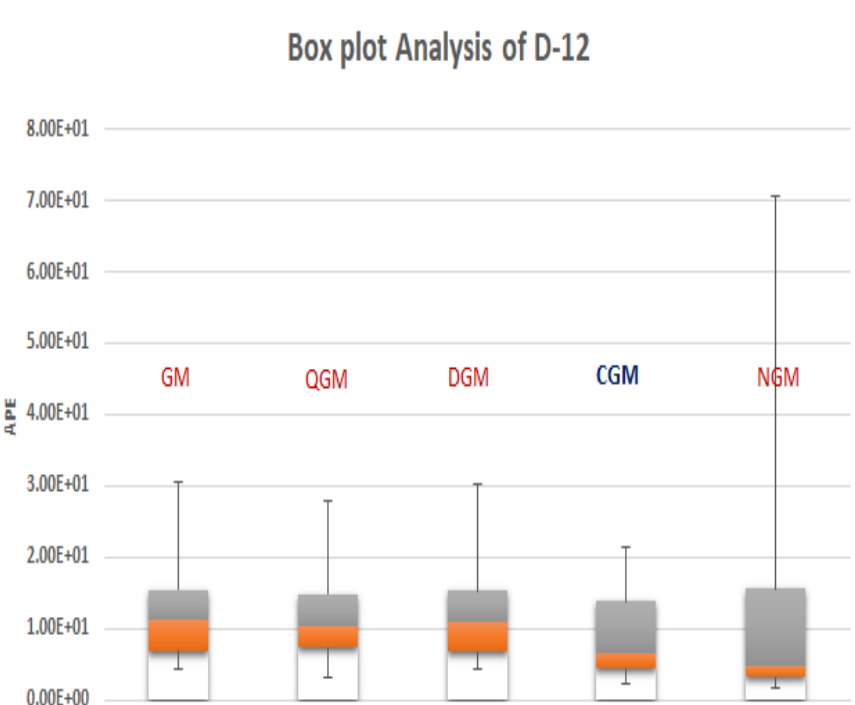
Figure 7. Boxplot analysis for